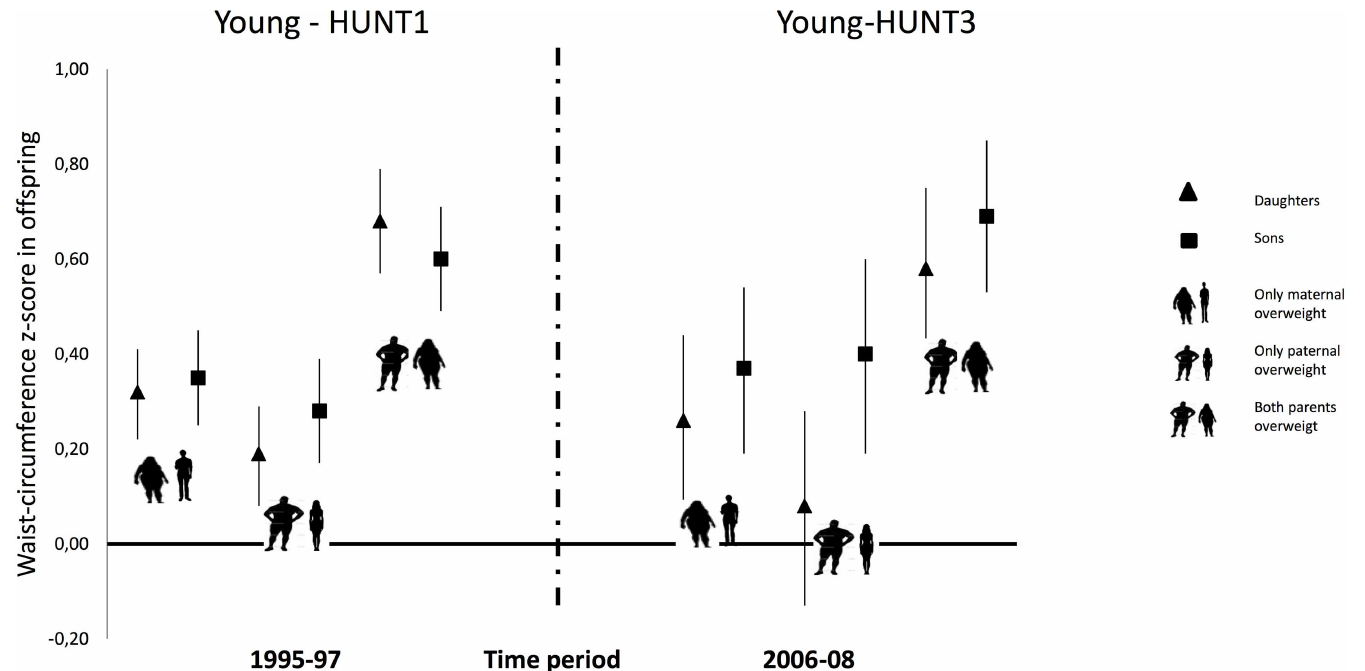
Fig 3. Associations in waist circumference. Associations betweenparentalwaist circumference-basedoverweight (related to WHO‘s cut-off level) and offspring‘s waist circumference z-scores at two time points (1995–97and 2006–08),with both parents being overweight, only mothers being overweight and only fathers being overweight, comparedto both parents being normal weight.